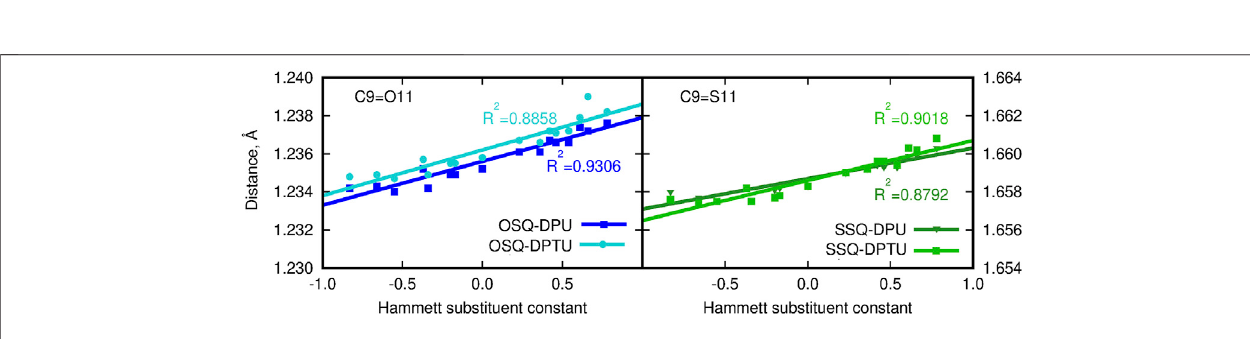
Frontiers in Chemistry |